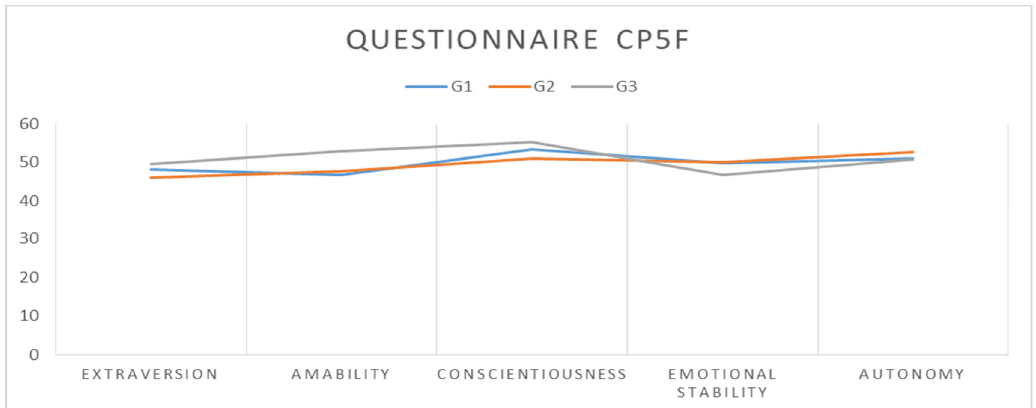
Figure 1. Representation of the arithmetic means recorded by the three groups for each CP5F sub- scale.